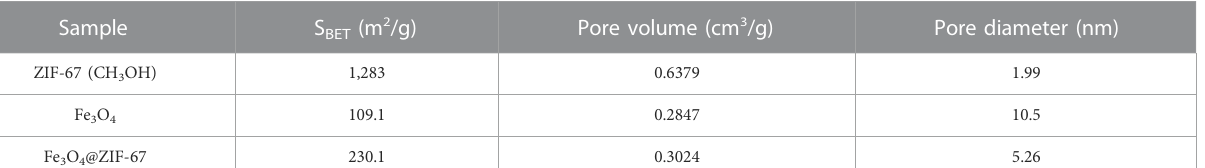
TABLE 2 Textural properties of Fe 3 O 4 @ZIF-67. Sample